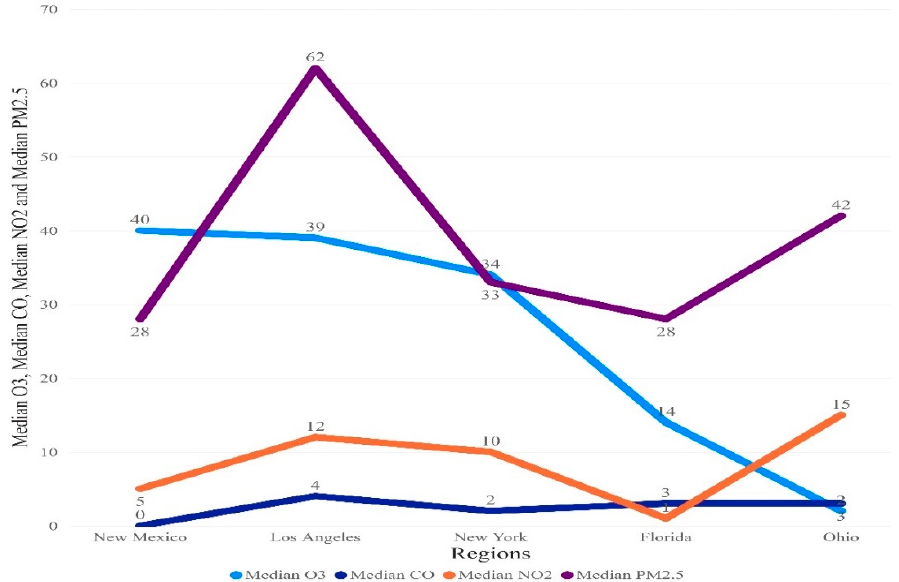
Figure 3. Median of pollutant parameter by region.